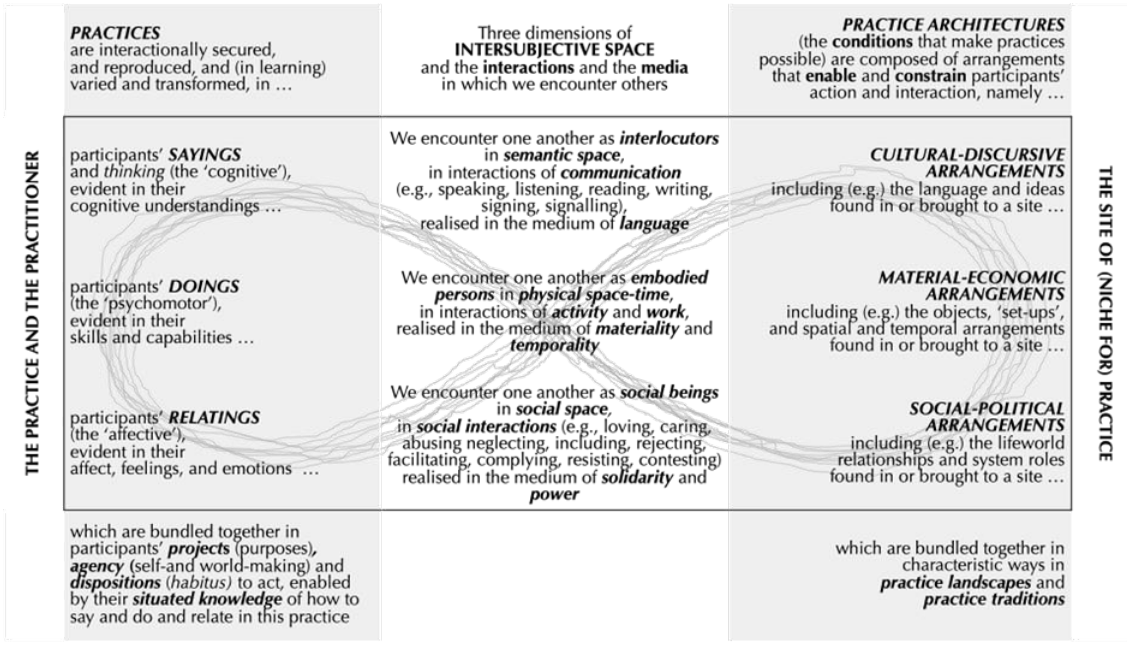
Figure 2. The dialectic of practices and arrangements (practice architectures). Adapted and reproduced with permission from Kemmis et al. (2014), p. 38, and Kemmis (2022), p.